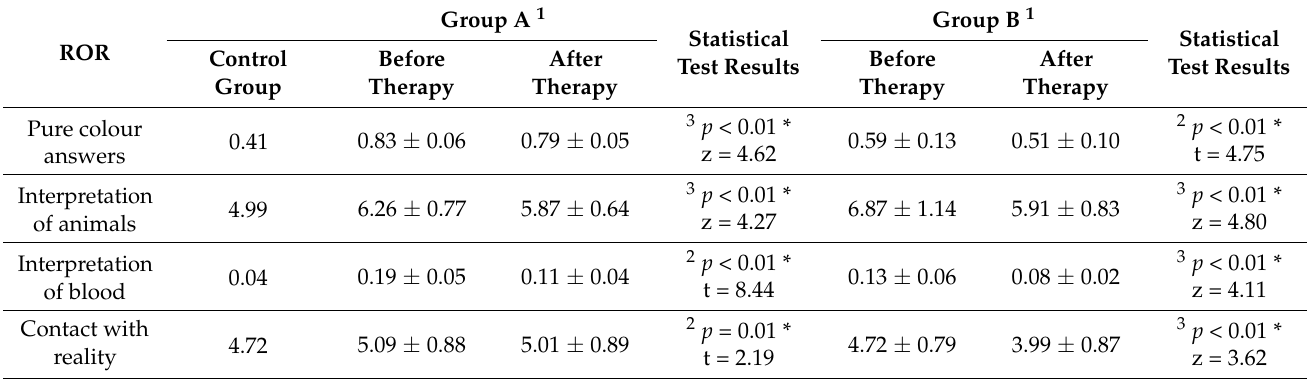
Table 1. Group averages of ROR test before and after forest